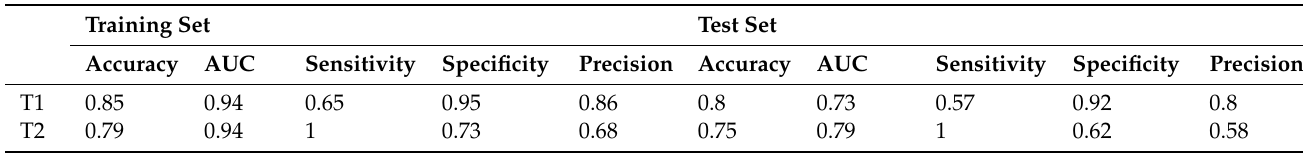
Table 2. Model performances.